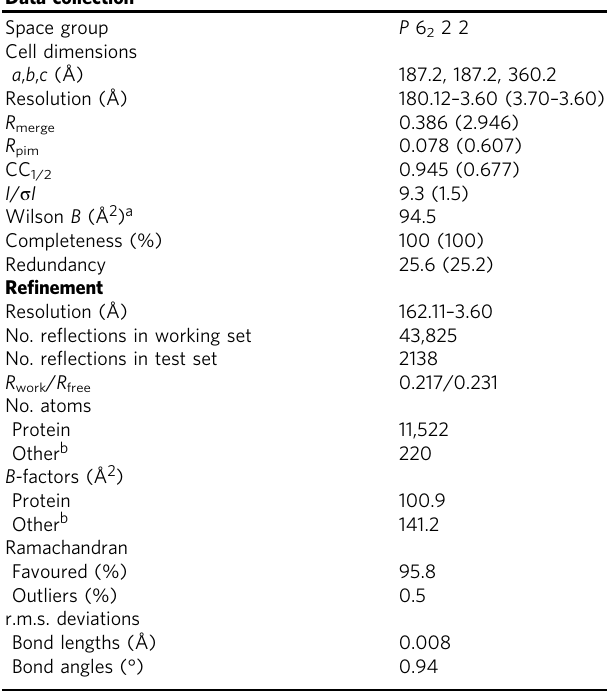
Table 1 Data collection and re fi nement statistics Data collection